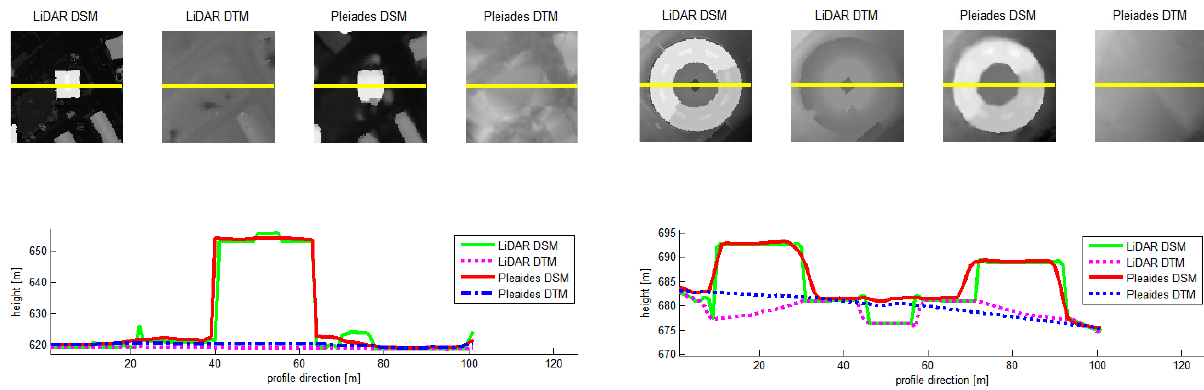
Figure 9. Profile comparisons of DSMs and DTMs from LiDAR and Pléiades for two small